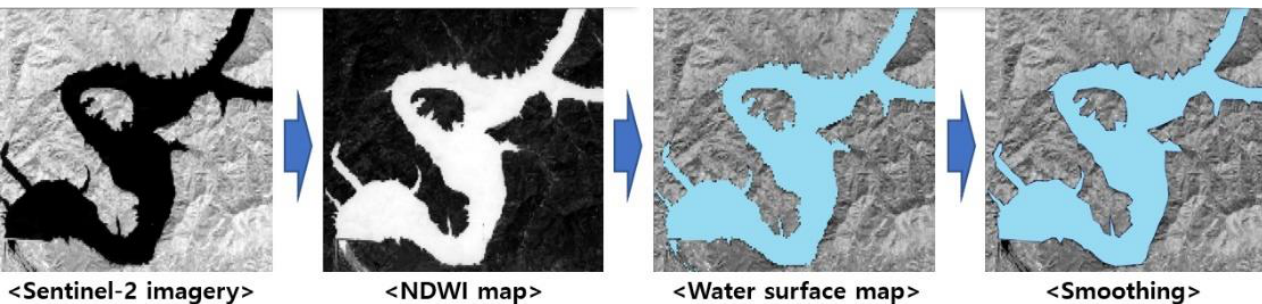
Figure 4. The water level – surface area – storage relationship from the digital elevation model of the Hwanggang Dam reservoir. ( a ) The water level – surface area relationship for the satellite-based wa- ter surface area. ( b ) The water level – storage relationship for the characteristic analysis of the reser- voir.